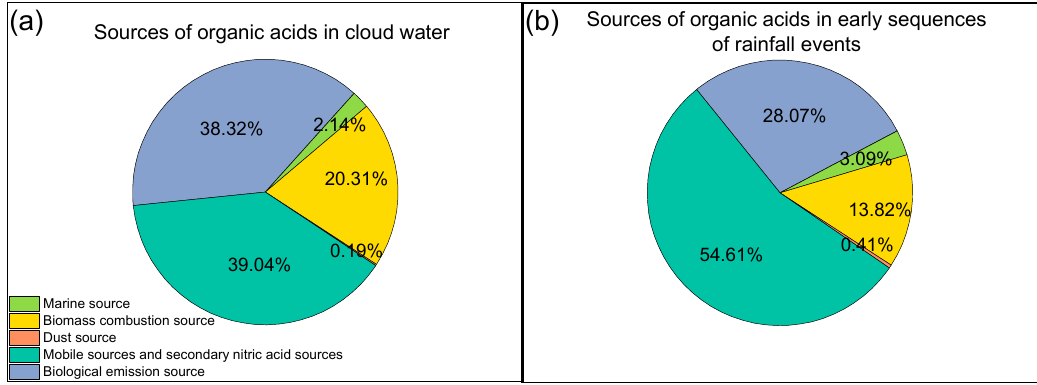
Figure 9. Illustrations of the percentage of factor contributions to organic acids in ( a ) cloud water and ( b ) early sequences of rainfall events.